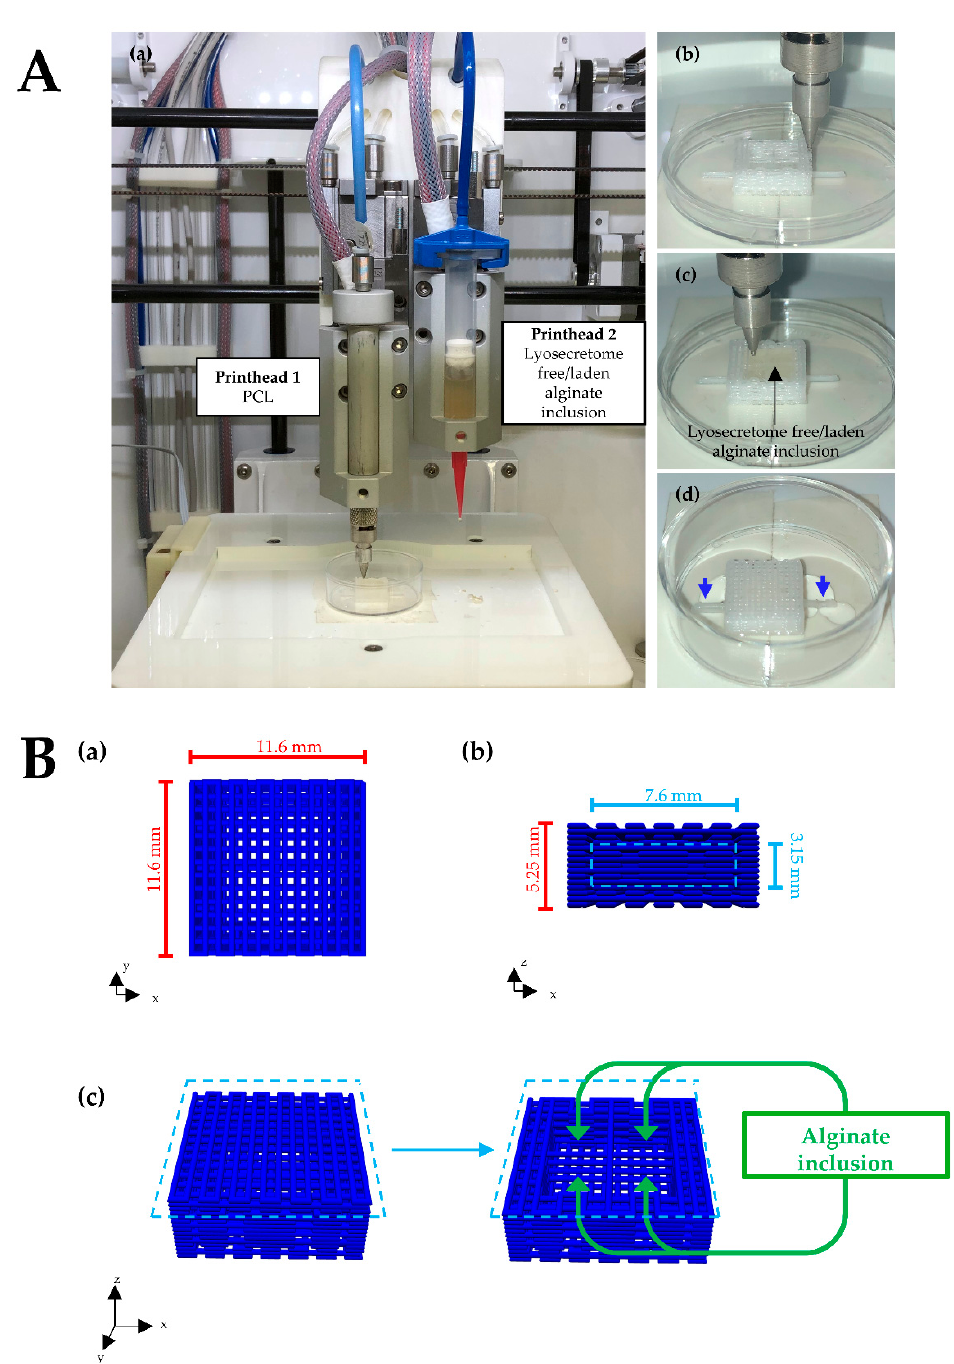
Figure 1. ( A ) Three-dimensional coprinting setup and process of PCL and alginate scaffold. ( a ) PCL and Lyosecretome-laden/free alginate were 3D printed using the PH1 and PH2, respectively. ( b ) The first part of the PCL scaffold was printed, forming the four wells in which alginate will be extruded. ( c ) After alginate extrusion, the last part of the scaffold was printed to cover the wells and create the inclusion. ( d ) Printed scaffold ready to be crosslinked with calcium chloride and protamine solutions. Blue arrows indicate two linear protrusions printed to block the scaffold into the well plate, avoiding floating during in vitro culture. ( B ) Scaffold geometry and dimensions: ( a ) planar, ( b ) sectional, and ( c ) total view of the scaffold with a focus on wells in which alginate will be extruded to form the